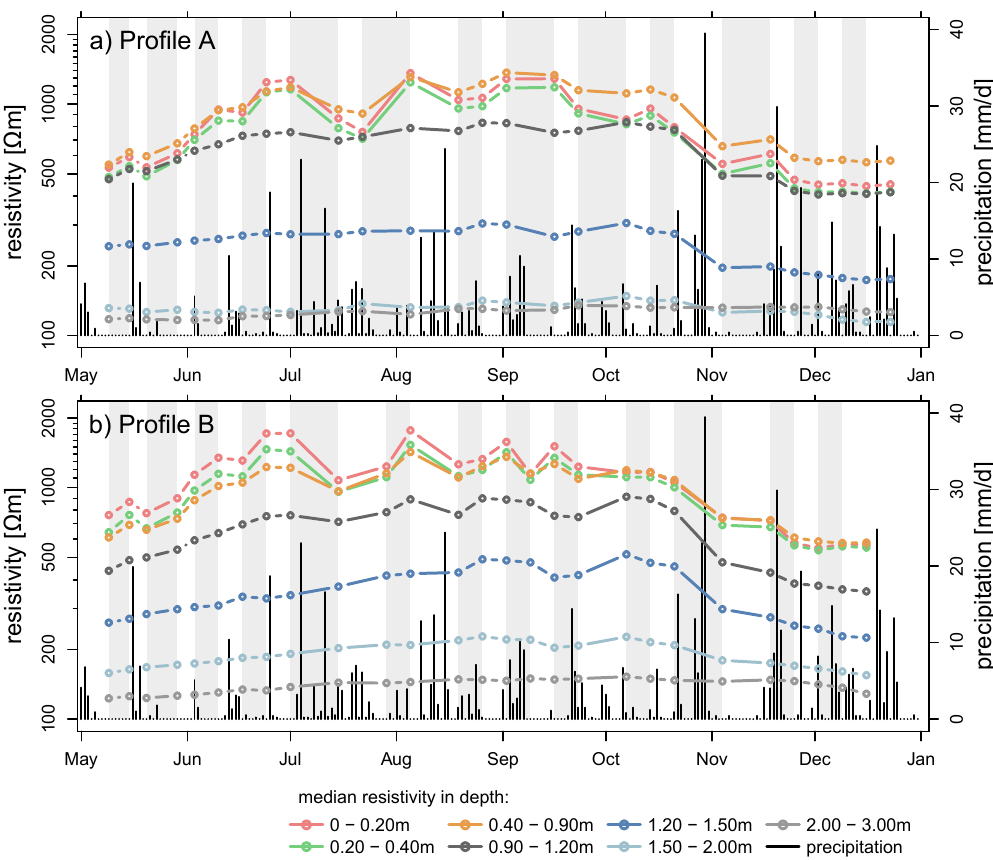
Figure 9. Trend of median resistivity for different depth ranges for (a) profile A and (b) profile B in comparison with daily precipitation (grey and white shaded regions for visualization of ERT time